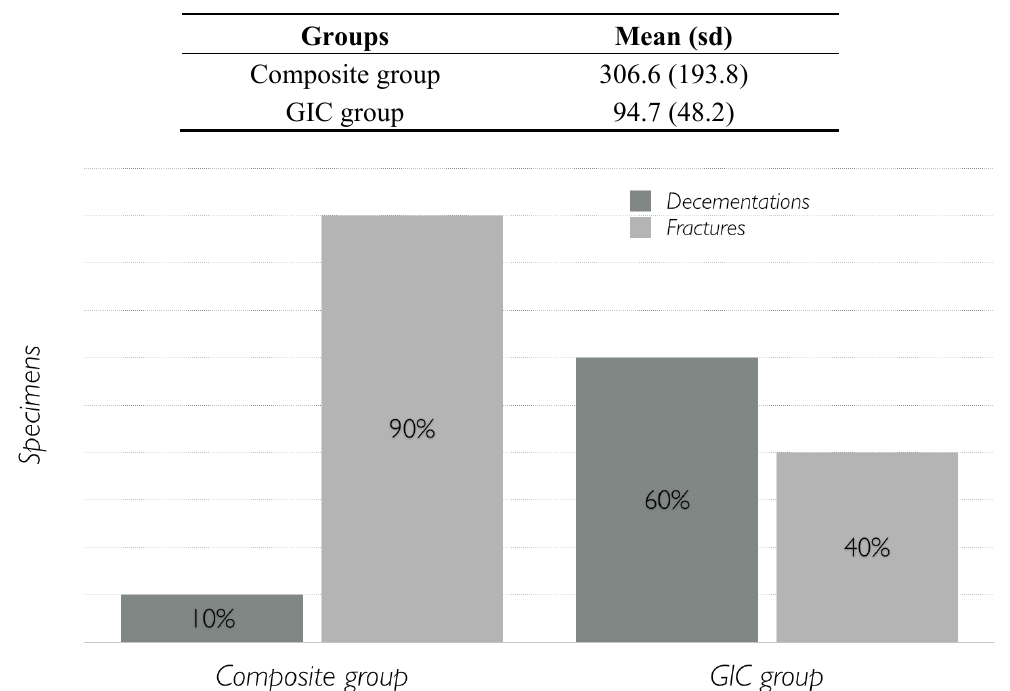
Figure 1. Results (percentages) divided according to failure